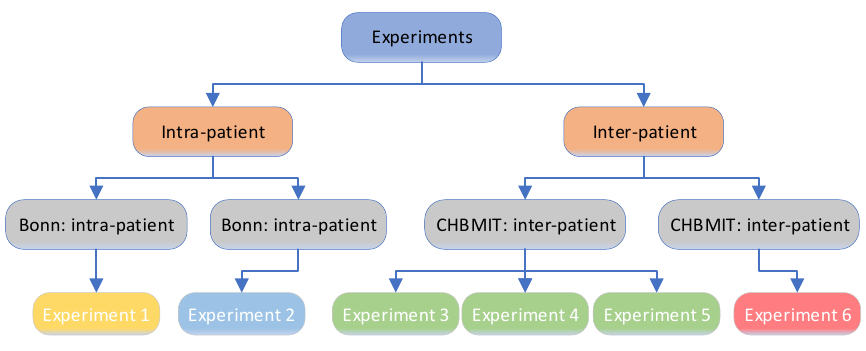
Figure 4. Experiments for model performance